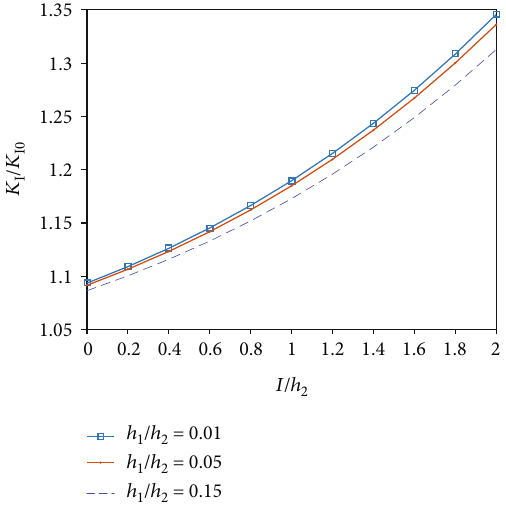
Figure 6: E ff ects of l / h di ff erent h